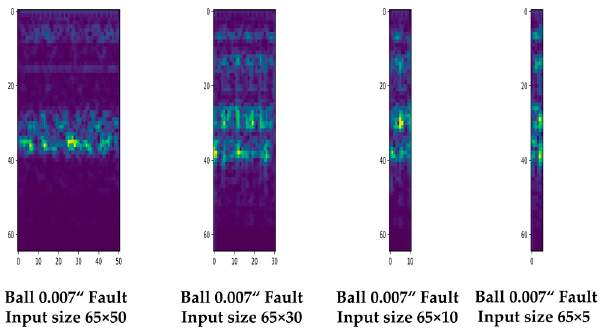
Figure 11. Examples of input spectrogram data of 65 × 50, 65 × 30, 65 × 10, and 65 × 5 sizes.